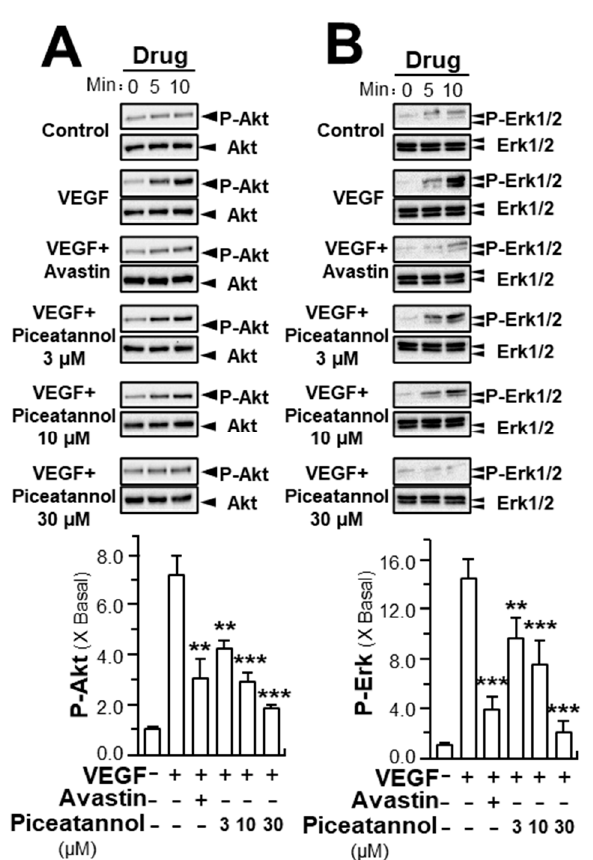
Figure 6. Piceatannol inhibits VEGF-induced phosphorylation of Akt and Erk. HUVECs were plated into each well of a 12-well plate at a cell density of 2 × 10 5 cells per well. The cells were treated by VEGF (10 ng / mL) with or without piceatannol. Cell lysates were collected after drug treatment at di ff erent time points as shown. Phosphorylated and total proteins of ( A ) ~60 kDa Akt, ( B ) Erk at ~42 kDa and ~44 kDa, were separately determined by western blotting analysis. Avastin (200 µ g / mL) served as a positive control. Data expressed as X Basal, where the control was set as 1, mean ± SEM, where n = 3; p < 0.01 (**); p < 0.001 (***) vs. VEGF-treated group.